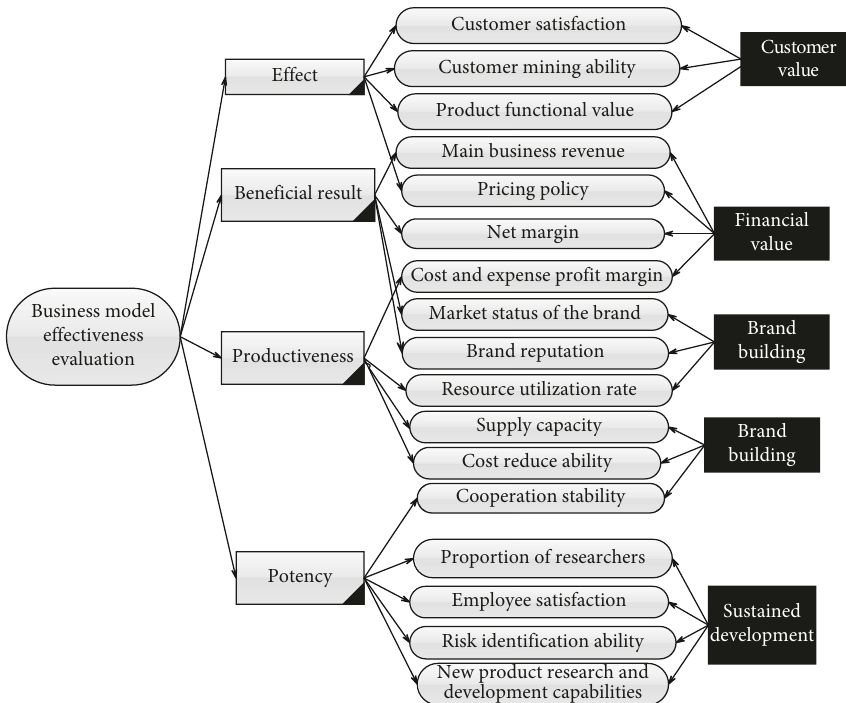
Figure 7: The evaluation index chart of the effectiveness of the technological startups business